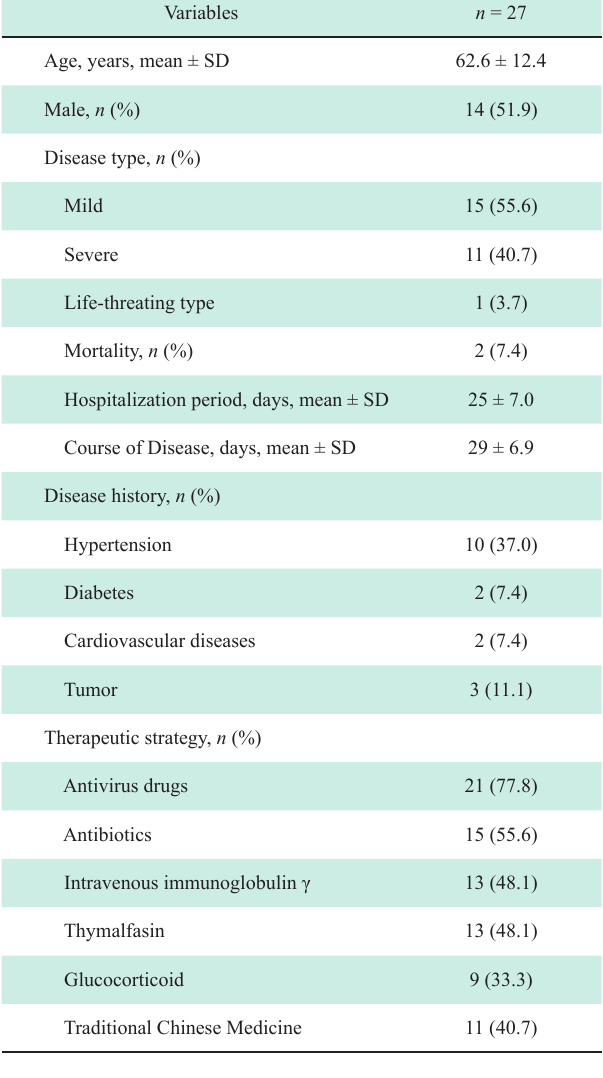
Table 1 Baseline features and disease history in 27 COVID-19 patients